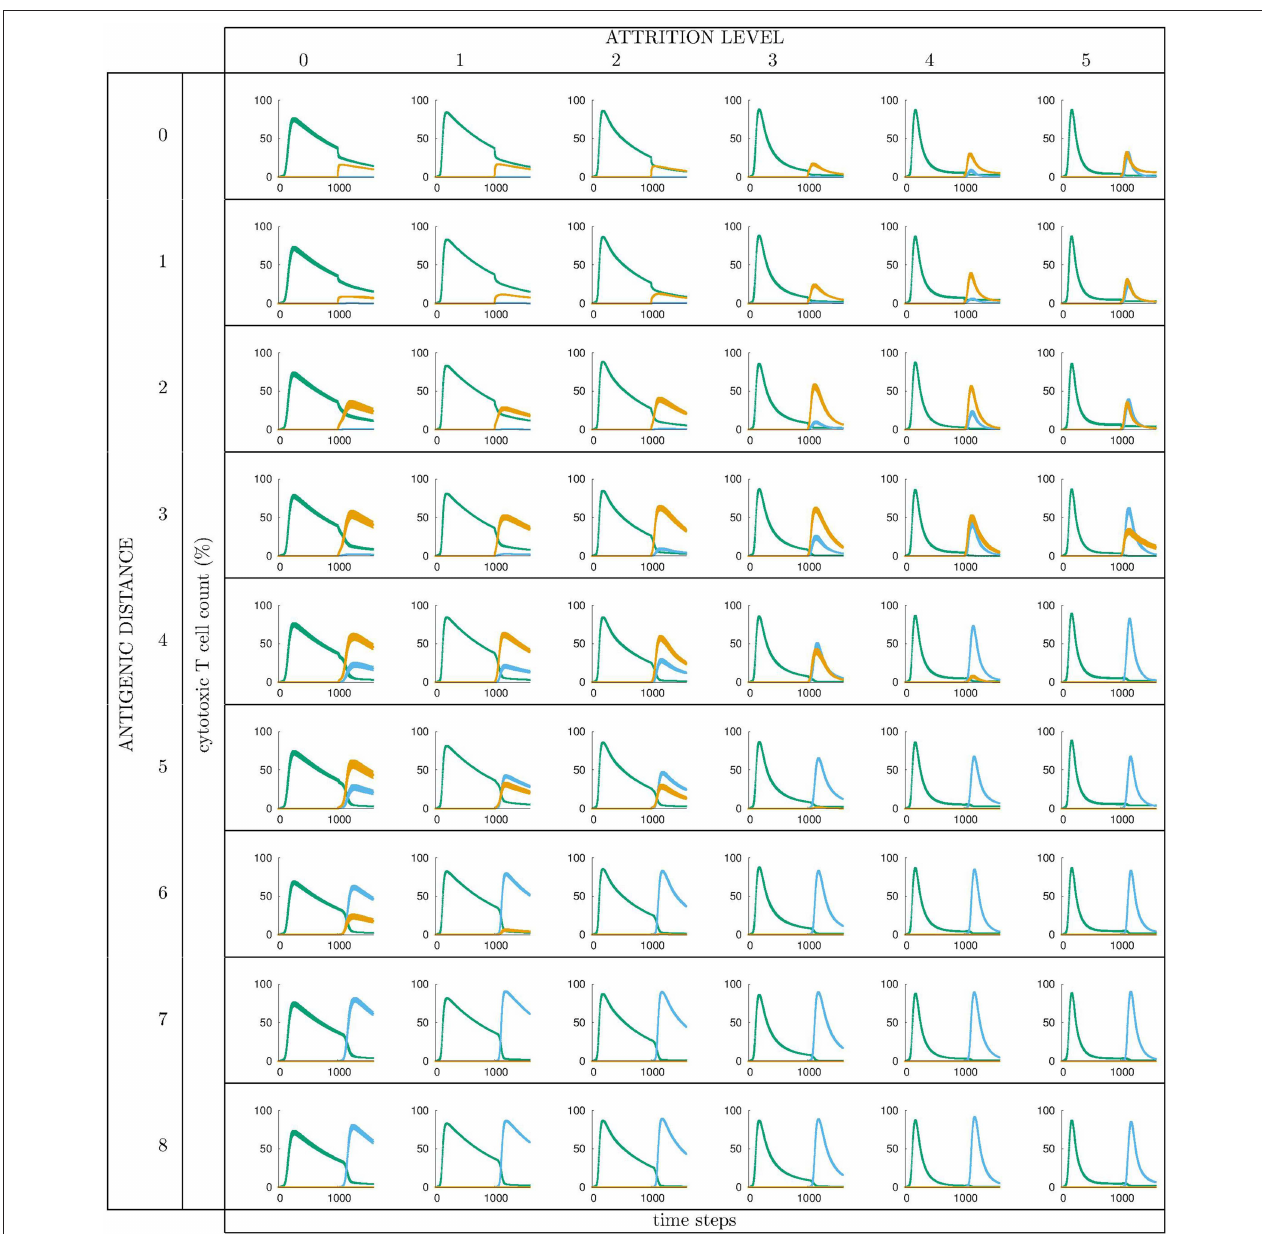
FIGURE 3 | Cytotoxic cell counts (percentage) vs. time. This is the result of different simulations obtained varying the level of attrition α = 0 ... 5 ( α = 0 is control case of no attrition) and the antigenic distance d between the two viral infections, for a total of 6 × 9 = 54 panels, each containing average ± standard deviation results of Tc counts in simulated primary viral infections, followed by a second challenge infection by an identical, or by a selected mutant virus. Color codes: green : response by naïve T effector cells to primary virus V I injected at t I = 0; orange : cross-reactive memory response primed by the first virus V I and challenged by V II ; blue : response by naïve T effector cells to V II injected at t II = 1000 time steps. See text for further explanation.